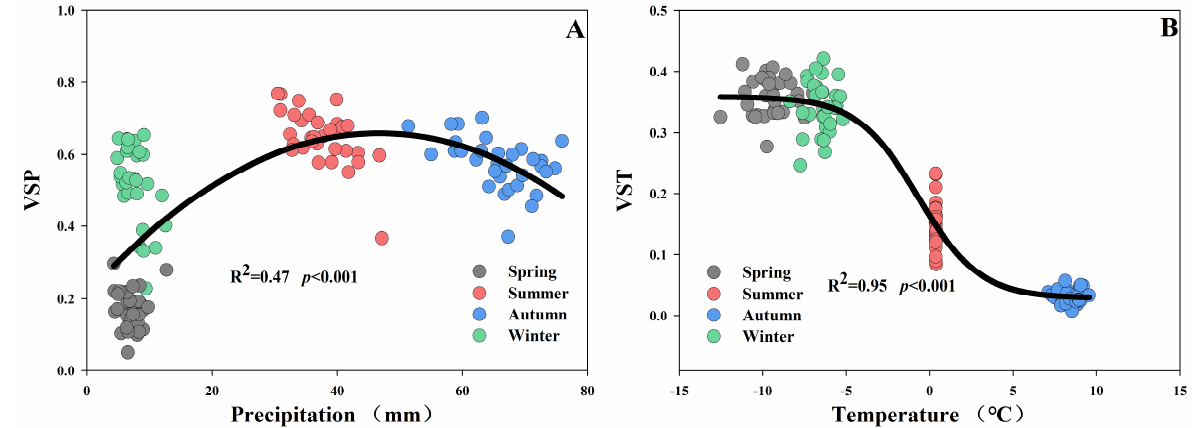
Figure 4. Variations in VSP ( A ) and VST ( B ). The gray, red, blue, and green points represent spring, summer, autumn, and winter, respectively.